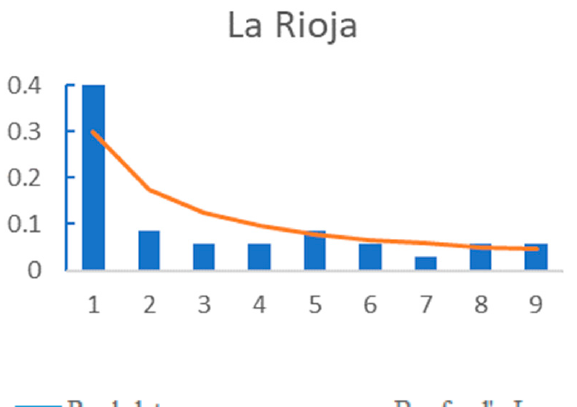
Figure 3. Frequency distribution of the first digit of the number of COVID deaths per day by AA.CC. (As in Figure 2, in this figure, the Y axes represent the frequency and X axes represent the first digit of the number of COVID deaths.).